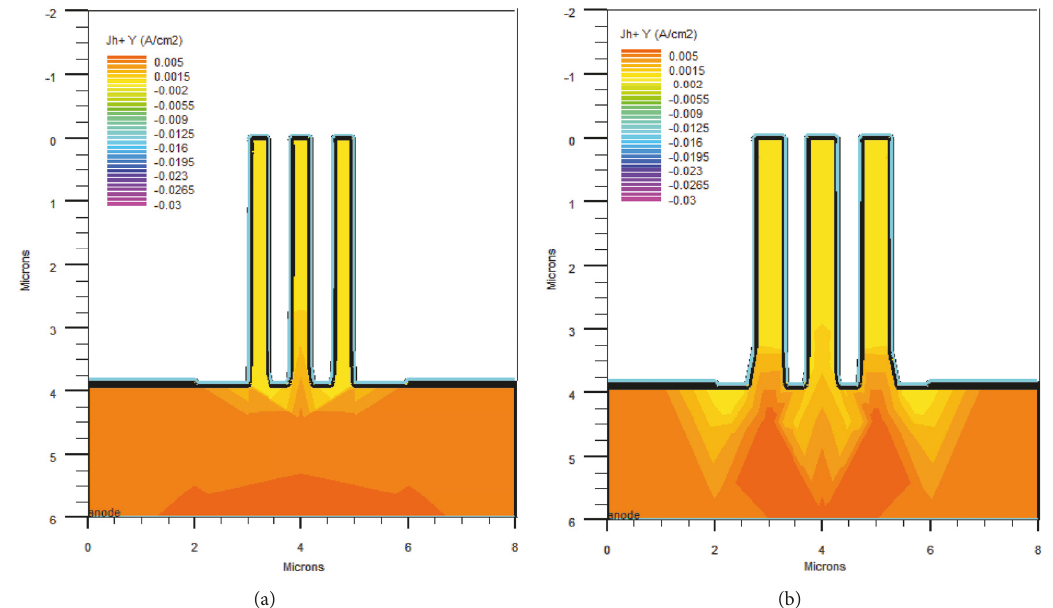
Figure 5: Cross section of holes current density distribution: ( a ) nanowires diameter set as 300 nm, periodicity set as 600 nm; ( b ) nanowires diameter set as 500 nm, periodicity set as 1000 nm.